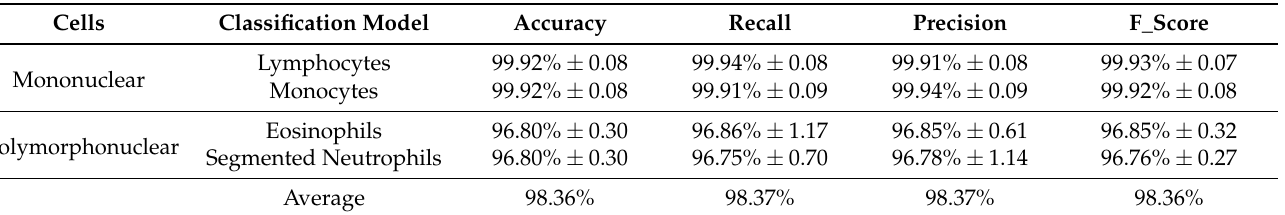
Table 3. Performance obtained in the classification model for each of the WBC cell types considered in the validation